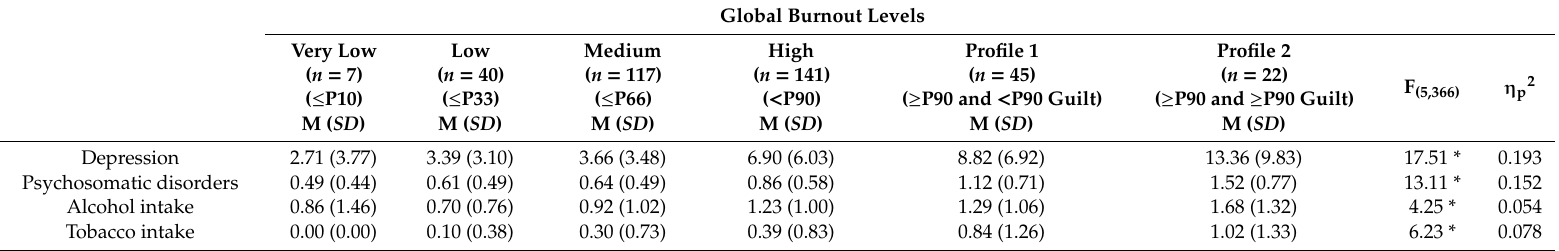
Table 2. ANOVA for consequences variables in the study, taking into consideration the levels of global